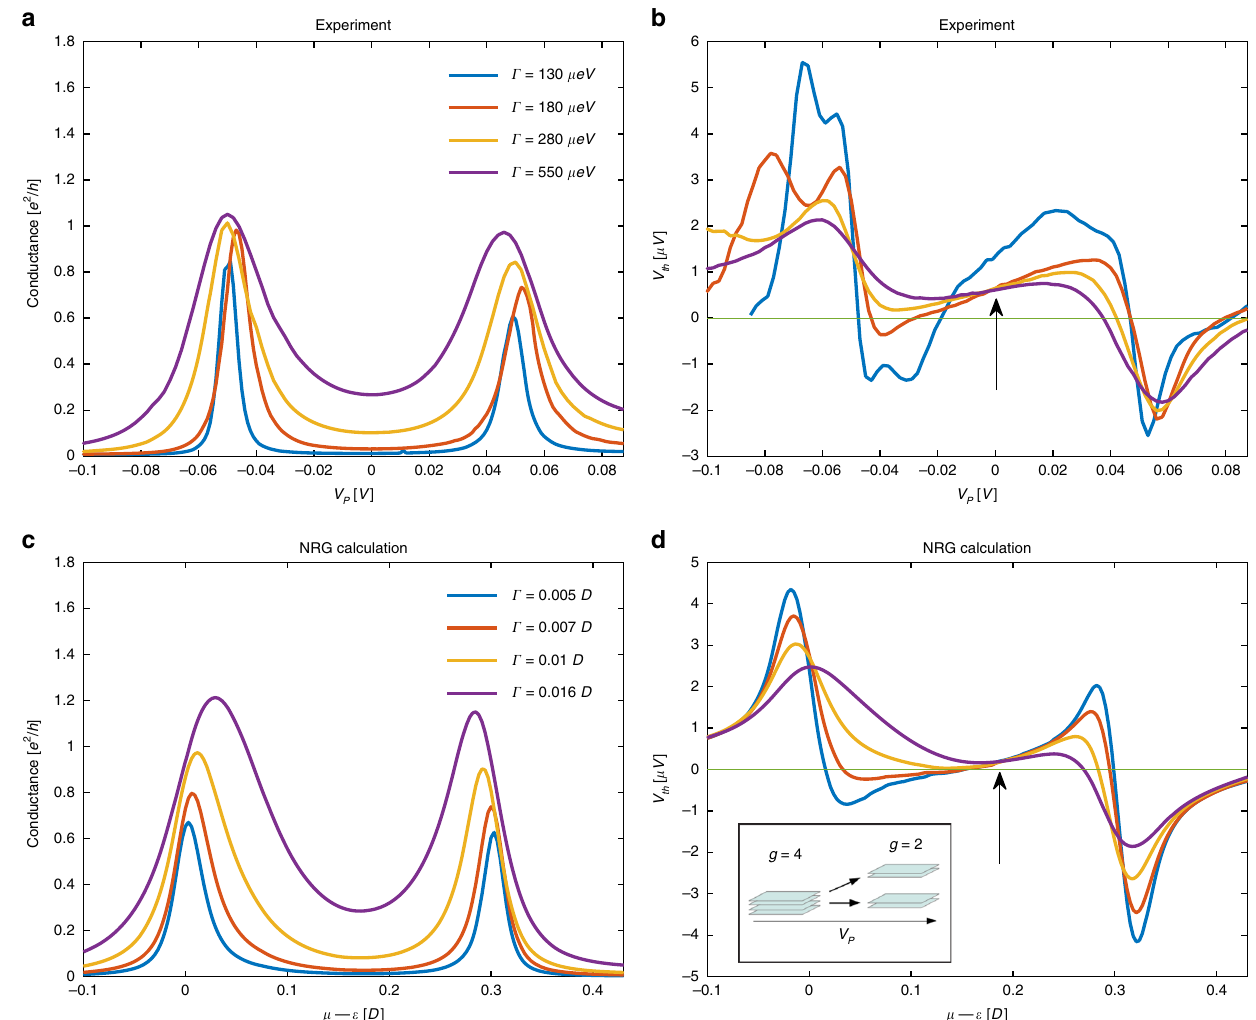
Fig. 4 Correspondence between numerical and experimental data for different couplings. Experimental measurements of a conductance and b thermovoltage through the same device as in Fig. 3, for several values of tunneling widths Γ . The anomalous nonzero value of the crossing point of the TR curves is denoted by an arrow (due to experimental ambiguity of reference chemical potential, the different curves were aligned so that the apparent particle-hole symmetry point is shifted to V P ¼ 0). Theoretical NRG calculations of c conductance and d thermopower through a QD with two spin- degenerate levels, with linearly varying level spacing, depicted in the inset to ( d ). The numerical plots were shifted horizontally so that the minima inside the valley for all plots coincided for alignment as in the experimental plots. The results also indicate a non-zero crossing point (arrow). The x -axes in c and d as well as Γ are in units of D , half the bandwidth in the leads, and we used U ¼ 0 : 3 D